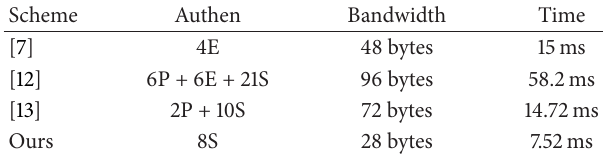
Table 3: Efficiency